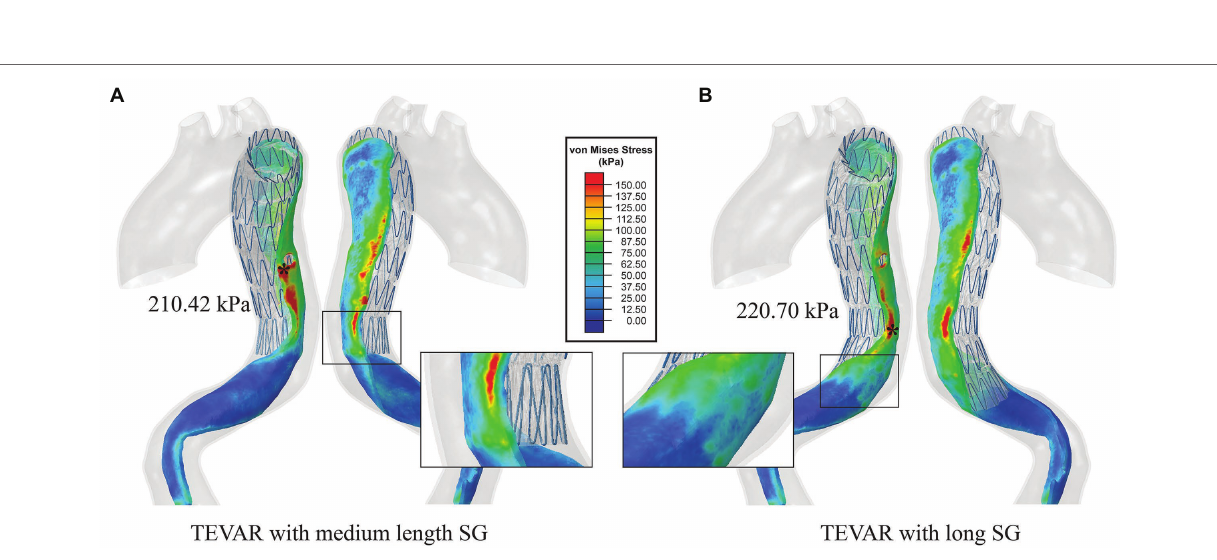
FIGURE 7 | (A) Von Mises stress maps on the intimal flap with the medium-length SG and (B) von Mises stress maps on the intimal flap with the long SG. The distal landing zones of the two scenarios were zoomed in to show the local stress distribution.